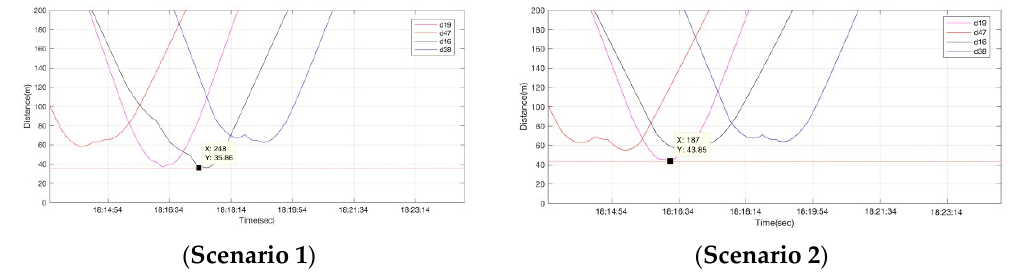
Figure 5. Minimal distance of UAVs for two scenarios.